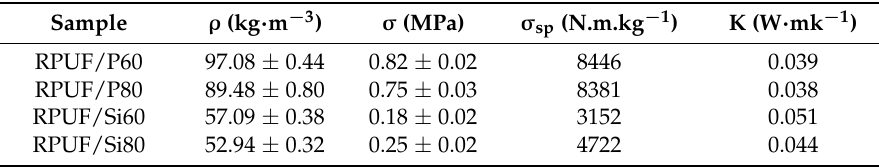
Table 8. Physical and mechanical properties of